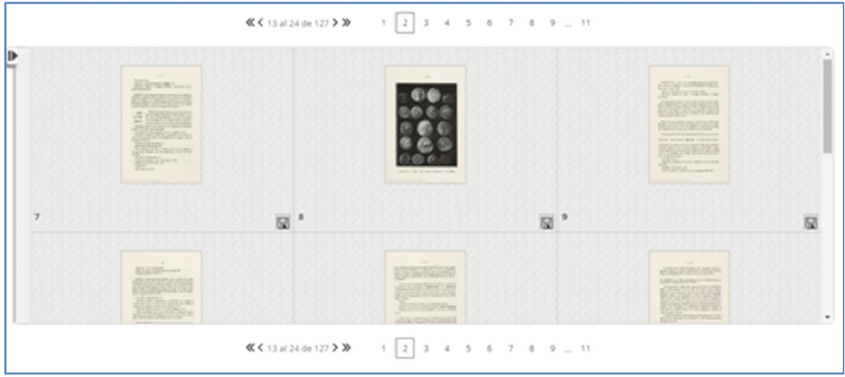
Fig. 4: Bibliographic record of the National Archaeological Museum Library, digitised in the Virtual Library of Bibliographic